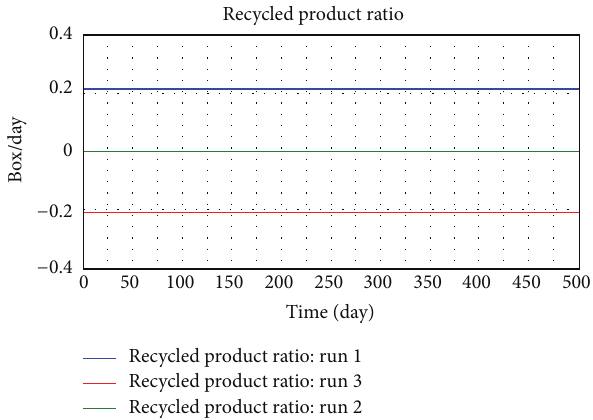
Figure 4: Product recycling ratio under different recycler reaction coefficients.